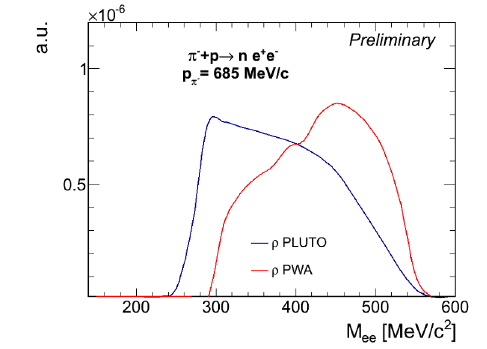
Figure 7. Simulations of the e + e − invariant mass distribution of the ρ decay contribution to the π − p → n e + e − at 0.685 GeV / c with mass distributions from a Breit-Wigner (blue curve, labeled ρ PLUTO) or deduced from the PWA of hadronic channels (red curve, labeled ρ